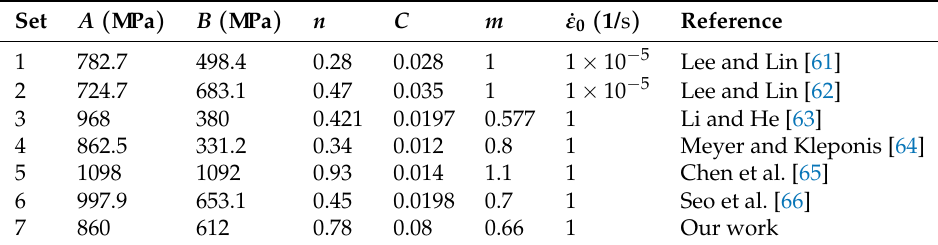
Table 1. The parameters of the Johnson-Cook constitutive equation for